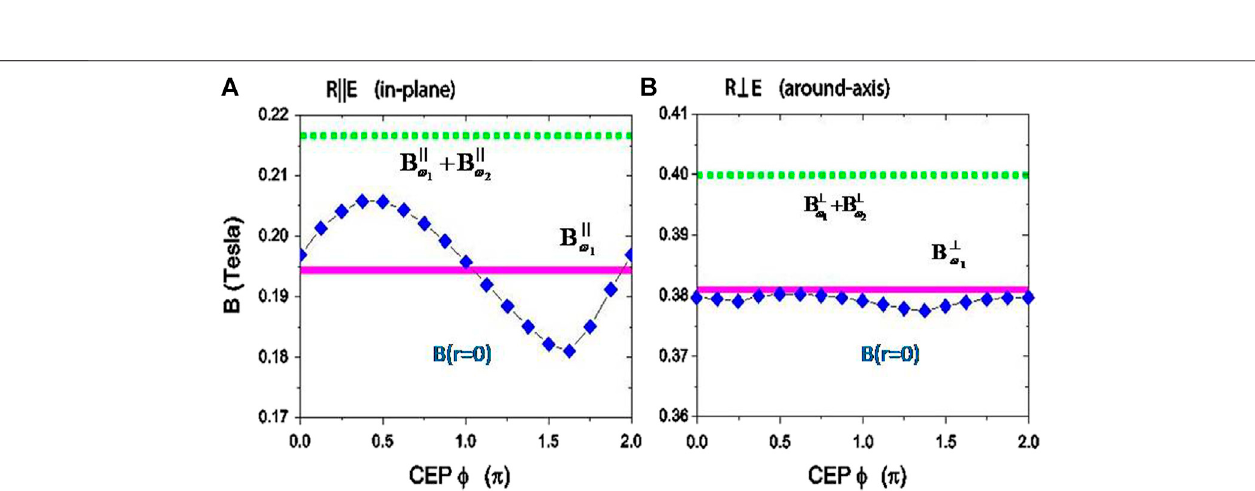
FIGURE 6 | Dependence of the maximum magnetic fi eld B (blue diamond) at the molecular center, r (cid:1) 0 on the relative pulse CEP ϕ (cid:1) ϕ 2 − ϕ 1 for the aligned molecule H + 2 by bichromatic corotating ( ϵ (cid:1) + 1) circularly polarized laser pulses with their fi eld vectors polarized in the ( x , y ) plane. Two cases are compared for the molecule aligned parallel to (A) the x axis and (B) the z axis, thatis, parallel R (cid:3) E in Figure 1A and perpendicular R ⊥ E in Figure 1B ,to thelaser ( x , y ) polarization plane. Pulsewavelengths λ 1 (cid:1) 70 nm( ω 1 (cid:1) 0 . 65 au)and λ 2 (cid:1) 35 nm( ω 2 (cid:1) 1 . 3 au),intensities I (cid:1) 1 × 10 14 W/cm 2 ( E (cid:1) 0 . 0534 au),andduration T lp (cid:1) 5 τ 1 (cid:1) 10 τ 2 (580 as FWHM) are fi xed. Magenta solid lines denote the generated magnetic fi eld B (cid:3) ω green dashed lines are the sum values of the magnetic fi elds B (cid:3) s (cid:1) B (cid:3) ω